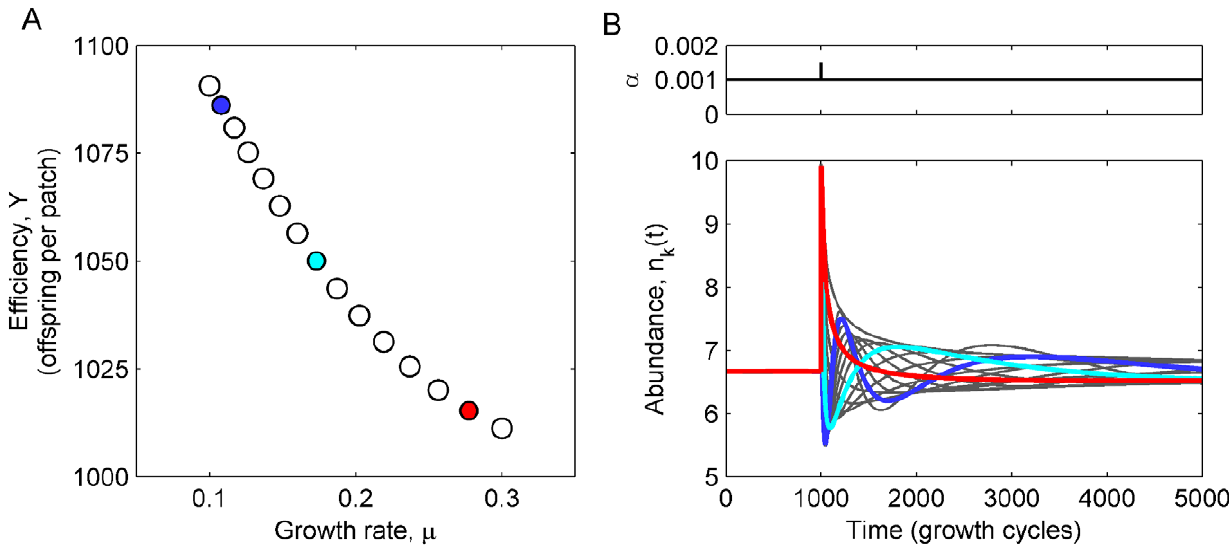
Figure 2. Multiple species can form stable communities given appropriate trade-off between growth rate and efficiency. (A) Growth rates and efficiencies for 15 species coexisting at fixed, equal densities ( n k =100/15 per patch; dispersal dilution a =0.001). (B) Time-trace of the system in panel A started at the fixpoint, but subjected to a perturbation in a in cycle t =1000 (spike in upper panel). The response of the 15 species is shown in the lower panel: the three representative species marked in color in panel A are shown with heavy lines, the remaining with thin grey lines. The perturbation drives the species abundances apart, but they relax back towards the steady state, indicating stable community coexistence (see also Methods).